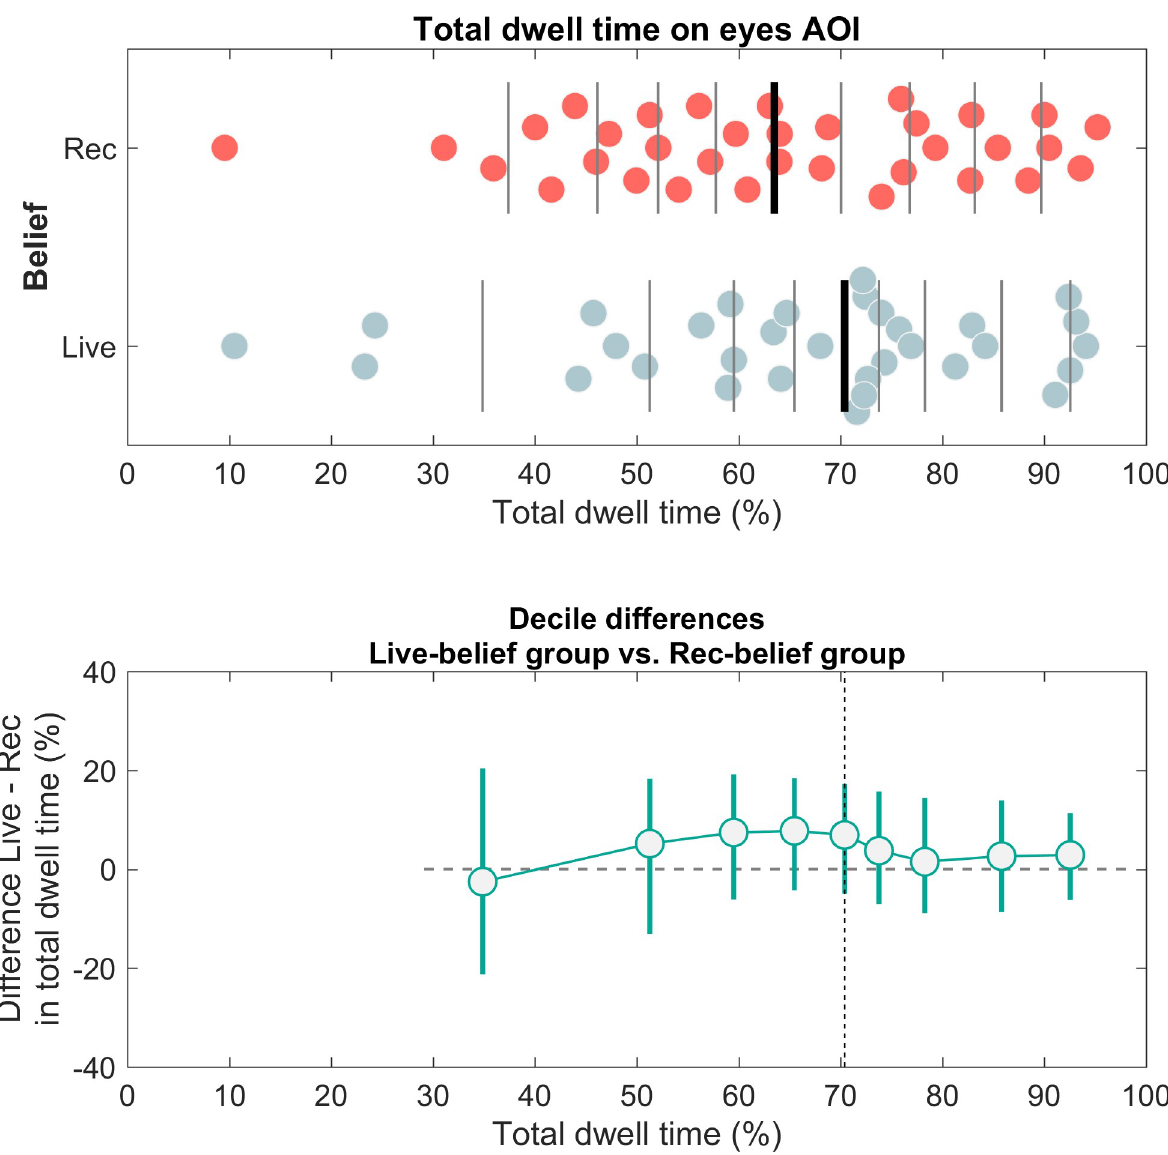
Fig 7. Distributions of relative total dwell time on the eyes AOI as a function of participants self-reported ‘beliefs’ (upper panel) and the corresponding shift function (lower panel). Upper panel: Distributions of relative total dwell time (%) on the eyes AOI. Data points are jittered vertically to prevent overlap and each dot represents data from one participant. Participants are grouped according to their ‘belief’ in whether the presentation was ‘live’ or not (live-belief group N = 33, rec-belief group N = 34). Vertical lines mark the deciles of the distribution. The thicker vertical line represents the median (50 th percentile). Lower panel: The shift function for independent groups. The differences between deciles are plotted as a function of deciles in the live-belief group. Decile differences in relative total dwell time are plotted on the y-axis. The horizontal dashed line represents the zero-difference line. The vertical dashed line represents the median. The x-axis shows the deciles of the live-belief group and the y-axis shows the decile differences in relative total dwell